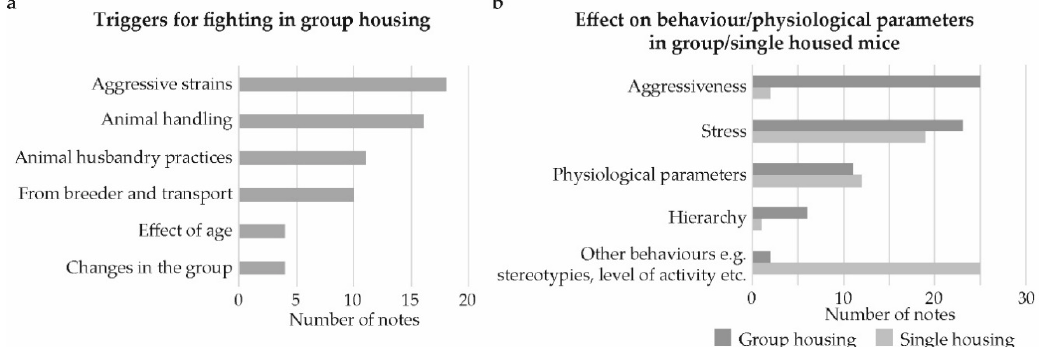
Figure 2. Problem inventory for group and single housing of male mice. Numbers of comments further categorized: ( a ) Describing situations and triggers for fighting when group housing male mice and, ( b ) further categorization of comments related to an effect on behavior/physiological parameters for both group and single housed male mice.